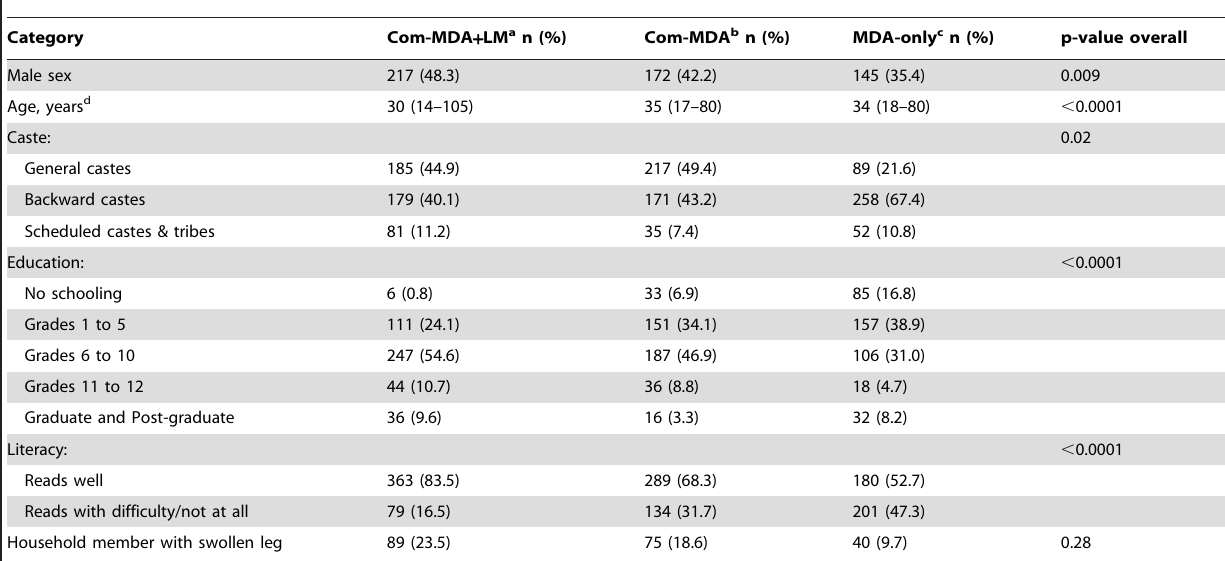
Table 2. Demographics for KAP survey participants for the 2008 MDA, Khurda District, Orissa State.